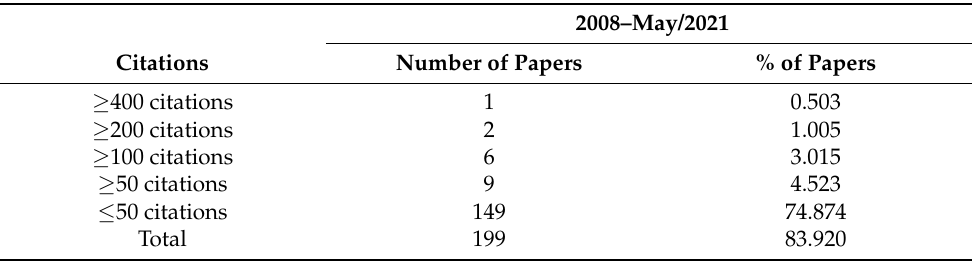
Table 2. General Citation on Renewable Energy, Economic Growth and Development Economic on Scopus.